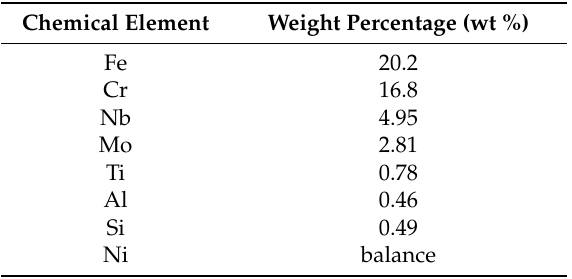
Table 1. The chemical compositions of the GH4169